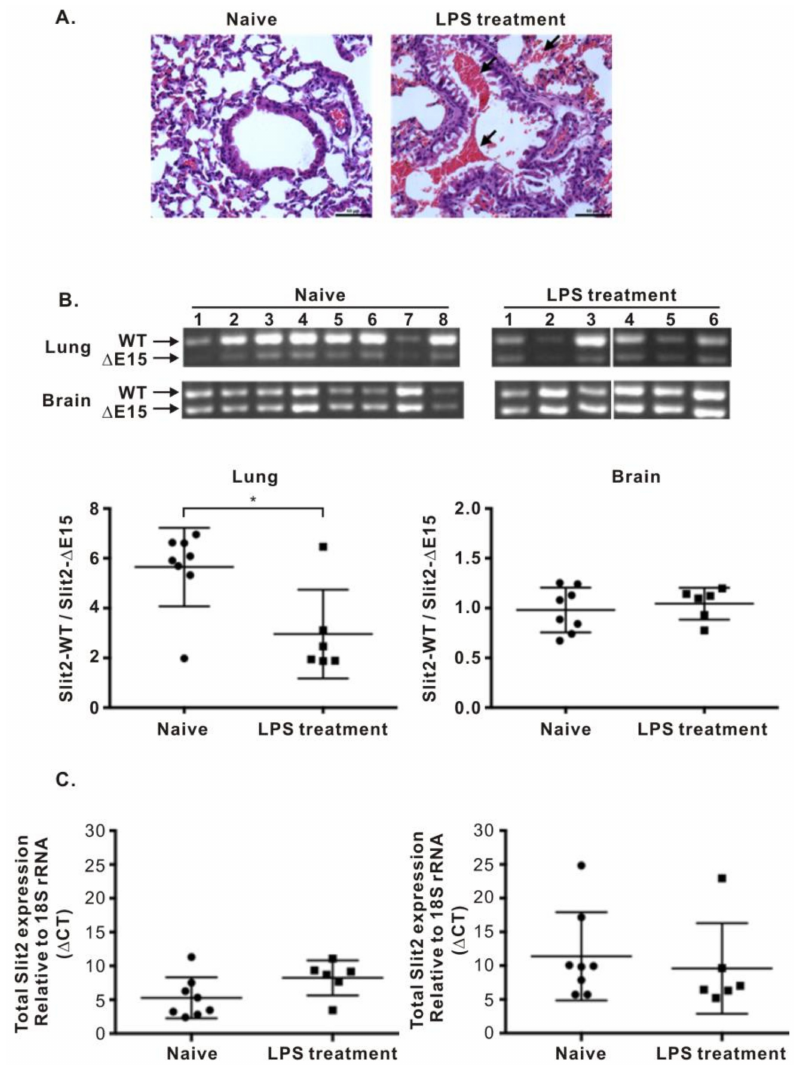
Figure 4. Effects of lipopolysaccharide (LPS) on Slit2 expression. ( A ) Lung inflammation induced by the LPS treatment. ( B ) Expression of the Slit2-exon15 isoforms in the lungs and brains of mice treated with an intranasal administration of LPS. ( C ) Total expression level of Slit2 in the lungs relative to 18S rRNA. ( D ) Total expression level of Slit2 in the brain relative to 18S rRNA. ( ∆ CT = CT slit2 − CT 18SrRNA ; CT: cycle threshold). Higher ∆ CT means a lower expression of Slit2. * p <